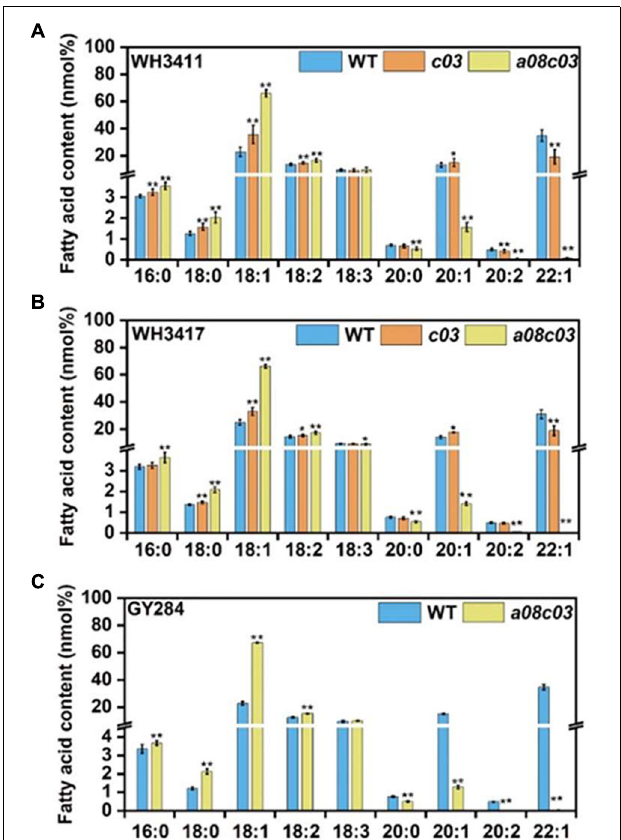
FIGURE 3 | The fatty acid composition phenotype of T2 mutants. Phenotype of fatty acid composition in WH3411 (A) , WH3417 (B) , and GY284 (C) backgrounds. c03 represents BnaC03.FAE1 homozygous mutant. a08c03 represents BnaC03.FAE1 and BnaA08.FAE1 homozygous double mutant. Values are means ± SD ( n = 3 ∼ 5). * P ≤ 0.05; ** P ≤ 0.01.